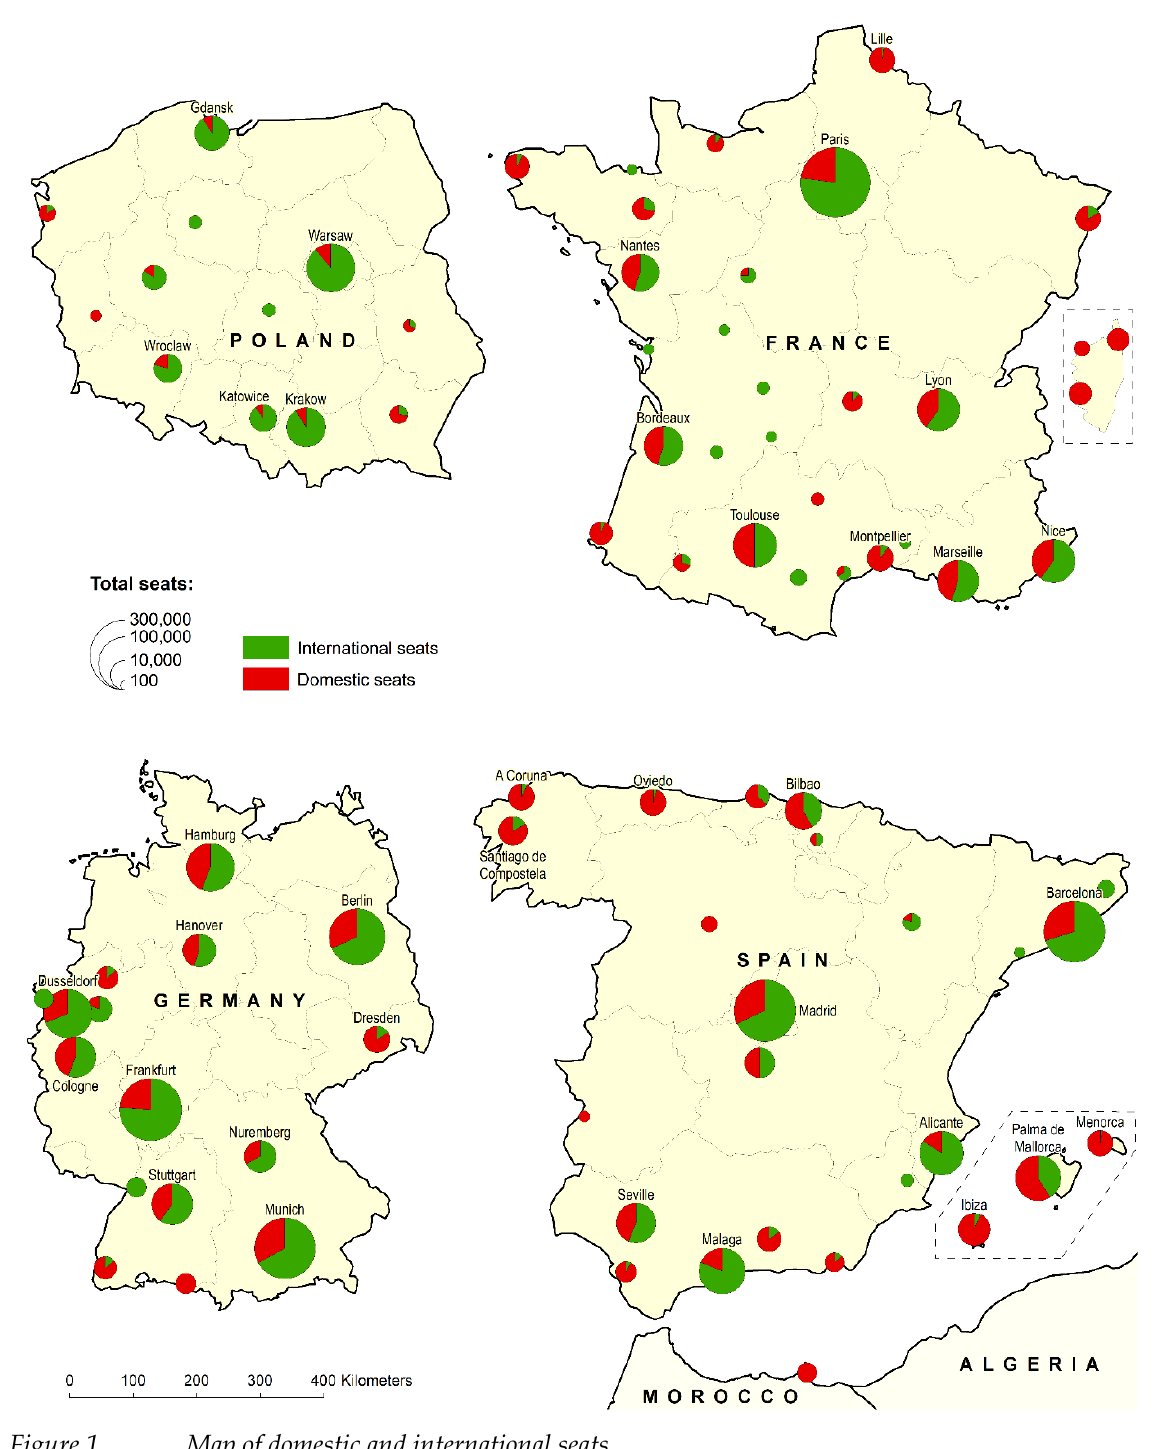
Figure 1. Map of domestic and international